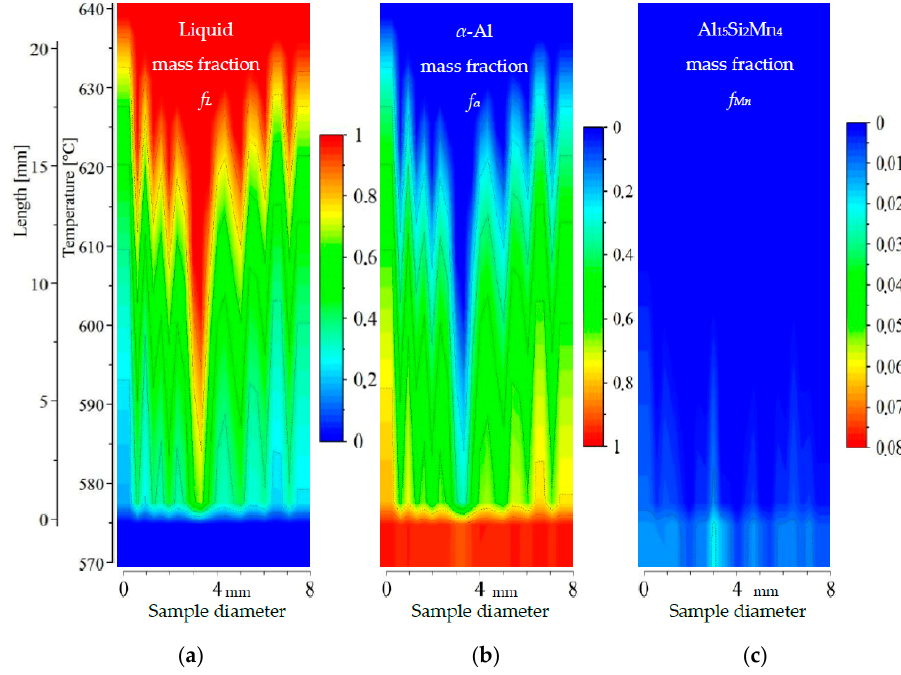
Figure 10. 2D maps of mushy zone for AlSi5Mn0.4 specimen: ( a ) liquid mass fraction f L ; ( b ) α -Al mass fraction f α ; ( c ) Al 15 Si 2 Mn 4 mass fraction f Mn in function of sample diameter and temperature/sample length.